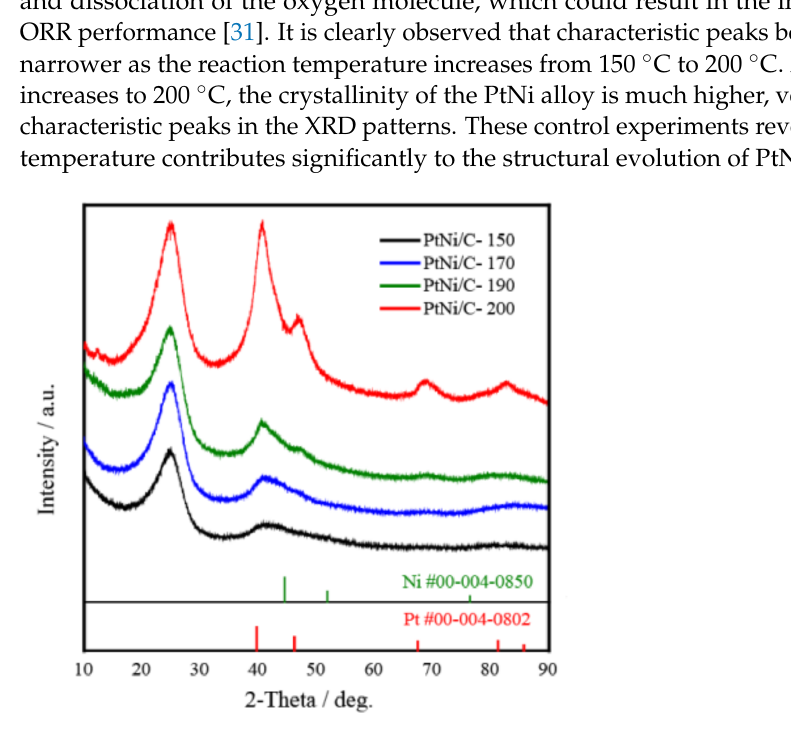
Figure 2. XRD patterns of PtNi/C at different reaction